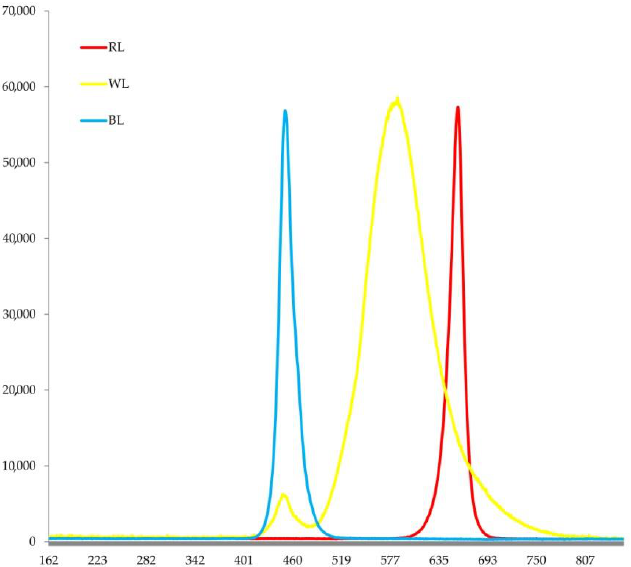
Figure 1. Emission spectra of various light sources used in the experiments, white light (WL), blue light (BL) and red light